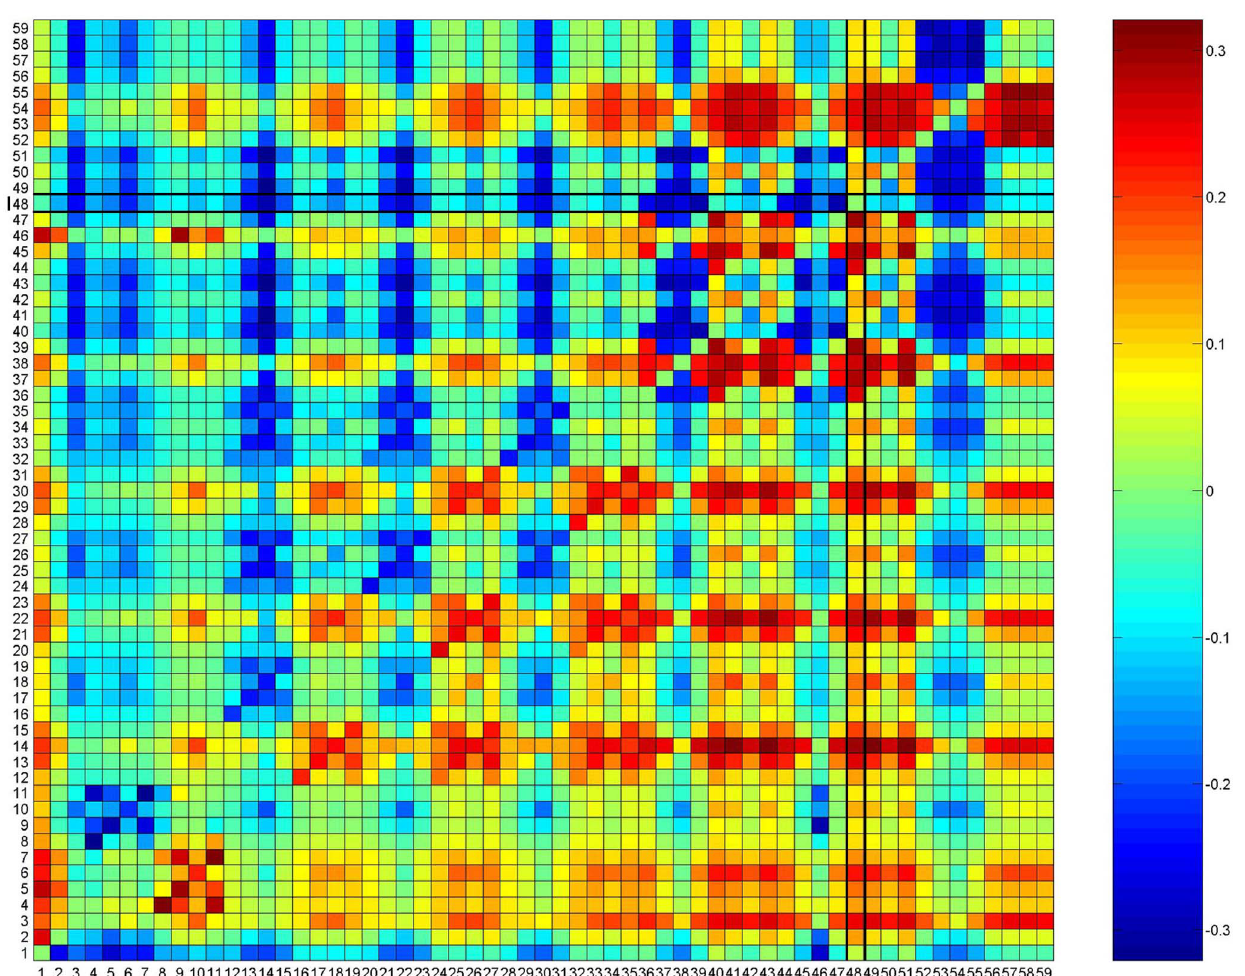
Figure 5. Reciprocal causal modeling results. Results of reciprocal causal modeling on the log transformed cost distances. A single resistance model (Model 48-Land_Fb100) is supported in analysis of the transformed cost distances. Columns indicate focal models, and rows indicate alternative models. The color gradient from blue to red indicates support for the focal model independent of the alternative model (e.g. focal model | alternative model – alternative model | focal model is positive). A fully supported model would have all positive values in the vertical dimension (e.g. that model is supported independently of all other models), and all negative values in the horizontal dimension (no other model is supported independently of the focal model). Model number and associated resistance map: 1 - EN, 2 - ENnb, 3 - Geo_dist, 4 - Land_A100, 5 - Land_A25.